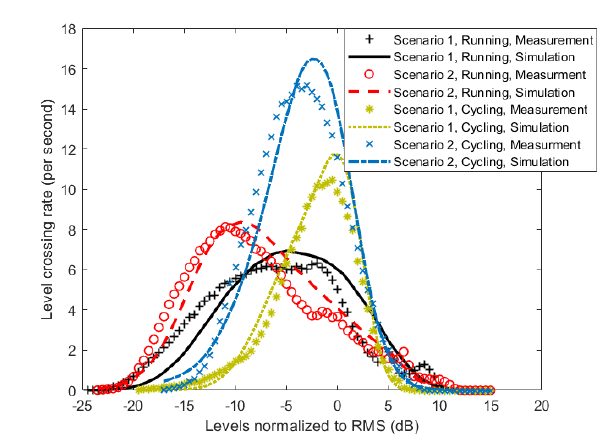
Figure 10. Comparison of level crossing rate (LCR) of the measurement results, and the developed simulated model results.